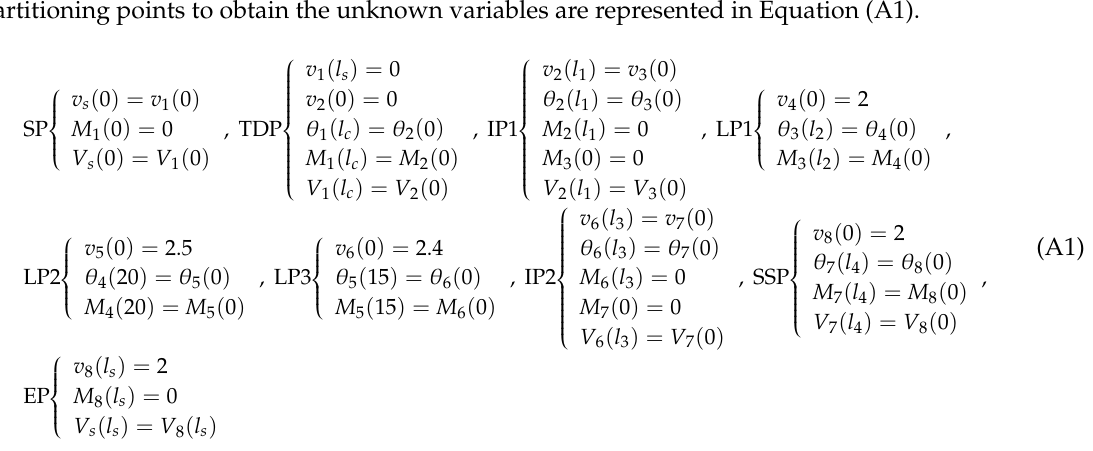
Equations for Each